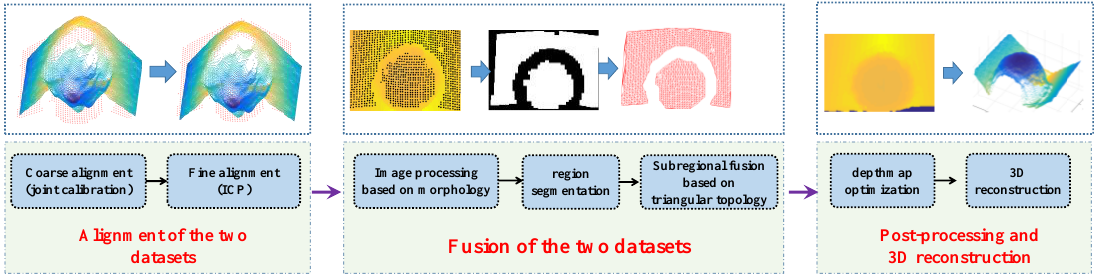
Figure 2. Pipeline of the proposed algorithm.